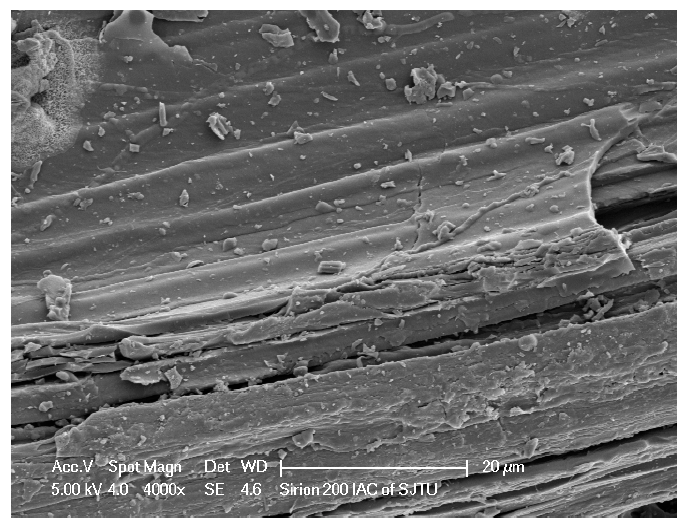
Figure 2. Scanning electron microscope (SEM) images of the morphological structure of the Fe-Cu/biochar system.